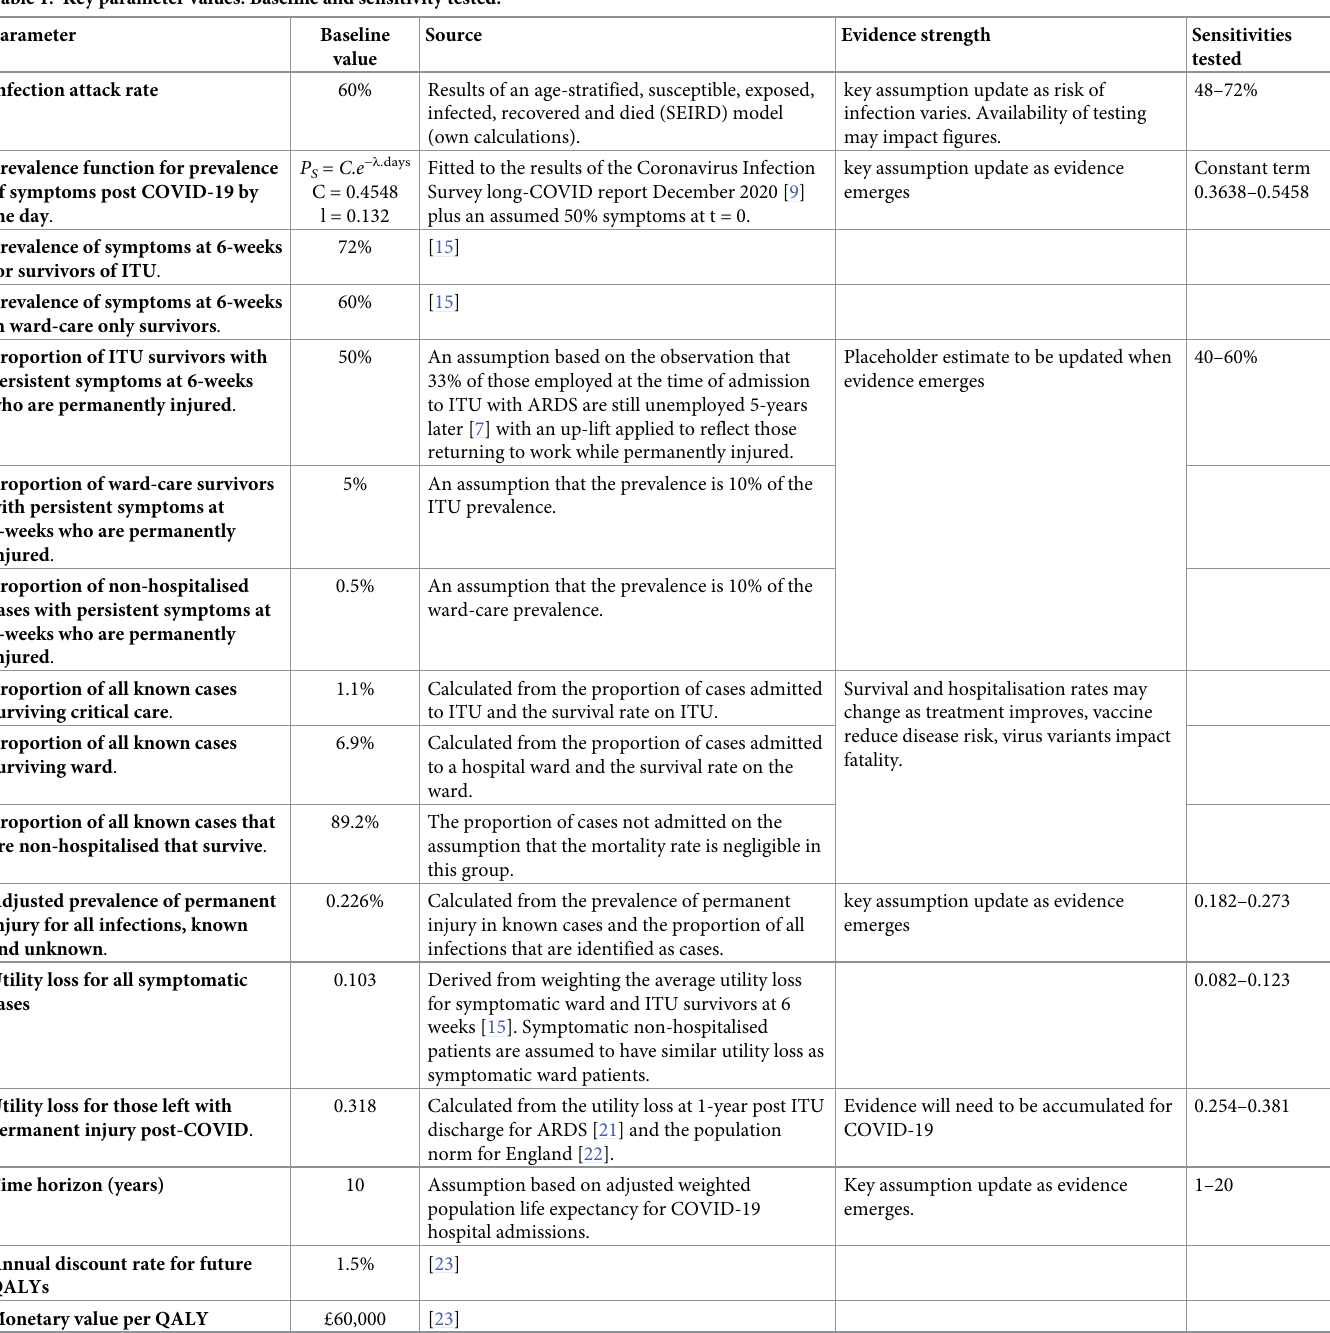
Table 1. Key parameter values: Baseline and sensitivity